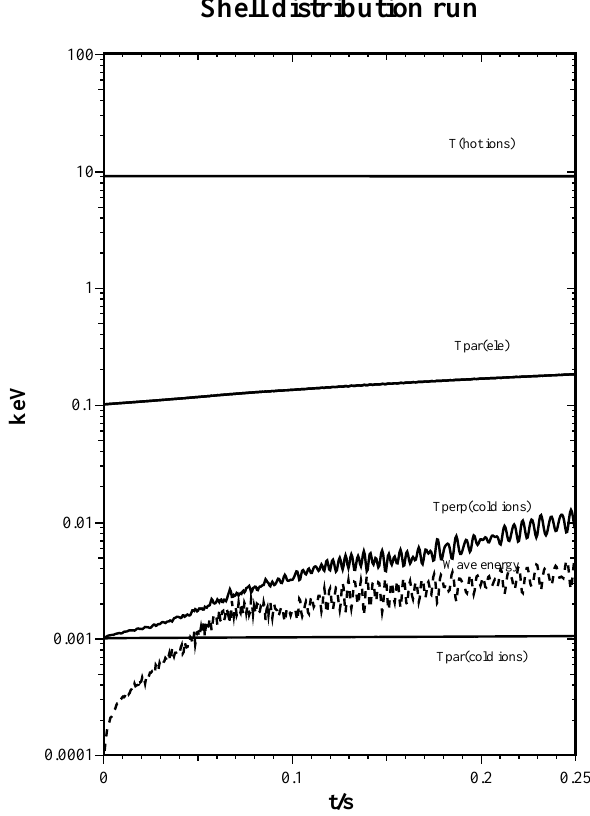
Fig. 13. Energy history of the shell distribution run. Same format as in Fig.